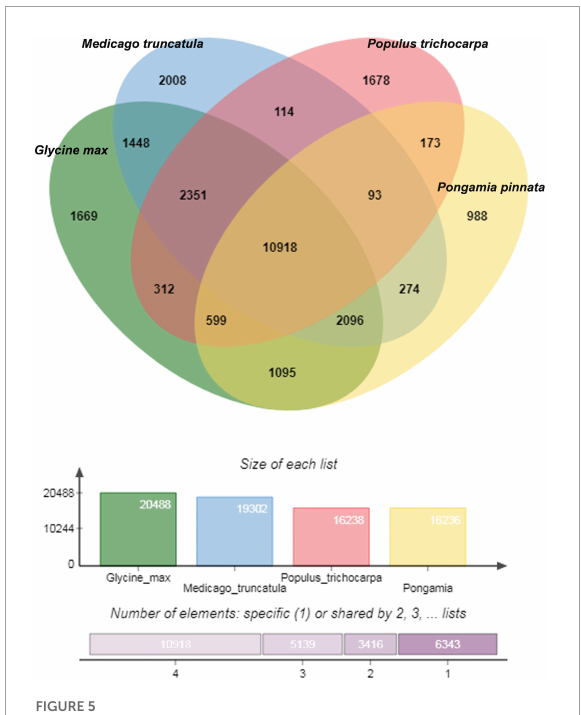
FIGURE5 A Venn diagram showing the uniformity between the orthologous proteins among four different plant species. A total of 16,179 proteins of pongamia identified in the current study were compared with that of Medicago truncatula, Populus trichocarpa , and Glycine max and found out the commonly shared proteins between 2, 3, and 4 species. Also represented 1,002 unique or uncharacterized proteins, which were not matched with any other protein in the existing